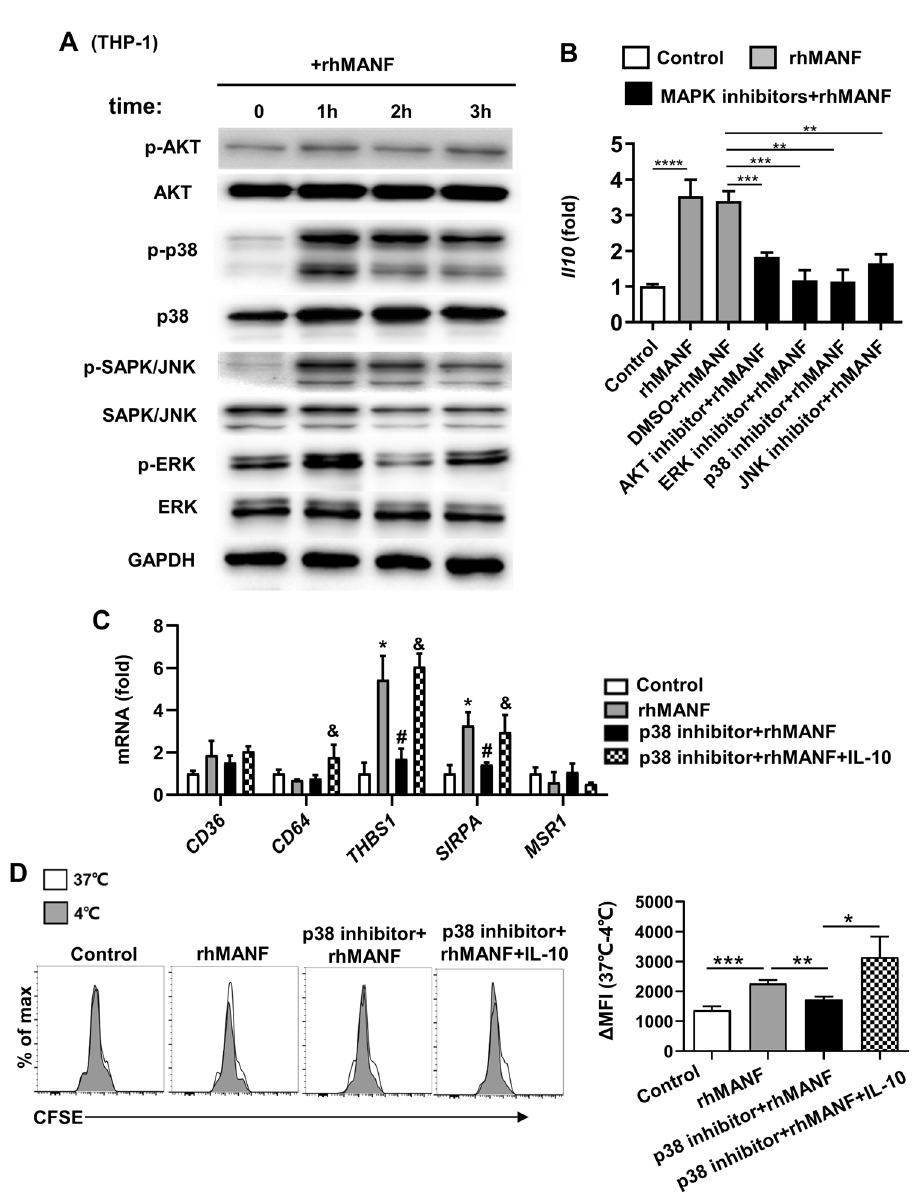
Fig. 8 MANF induces IL-10 expression and phagocytosis in human monocytes via the p38 signaling pathway. A THP-1 cells were cultured with rhMANF (2 μ g/mL) for the indicated times. Activation of various signaling pathways was measured by western blotting. B THP-1 cells were pretreated with various inhibitors for 1 h, followed by rhMANF (2 μ g/mL) treatment for 5 h. Il10 mRNA expression in THP-1 cells was measured by RT-qPCR. C , D THP-1 cells were cultured with p38 inhibitor for 1 h, followed by rhMANF (2 μ g/mL) with or without IL-10 (20 ng/ mL) treatment for 5 h. C Phagocytosis-related gene expression was measured by RT-qPCR. * P < 0.05 compared with control; #<0.05 compared with rhMANF-treated group, & <0.05 compared with p38 inhibitor + rhMANF-treated group. D Uptake of CFSE-labeled LO 2 cells by THP-1 cells were examined by fl ow cytometry and shown as Δ mean fl uorescence intensity at 37 – 4 °C. Data are presented as mean ± SD. n = 3/group, 3 independent experiments. * P < 0.05, ** P < 0.01. Cell Death and Disease (2022)